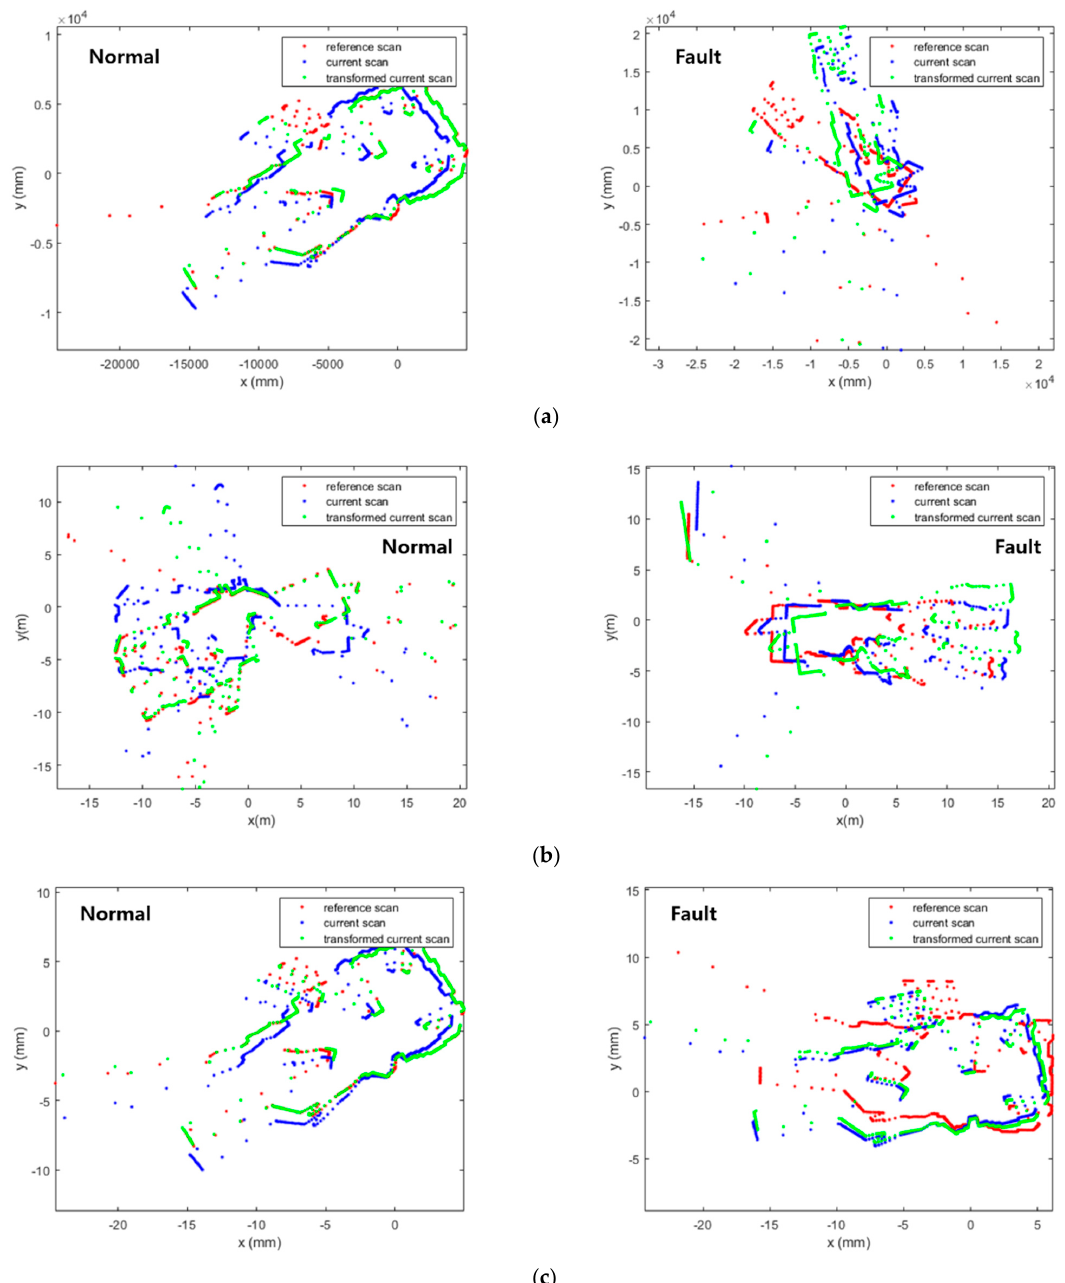
Figure 4. Normal and faulty scan matching with dynamic objects. ( a ) ICP (Iterative Closest Points); ( b ) PSM (Polar Scan Matching); ( c ) NDT (Normal Distributions Transform).